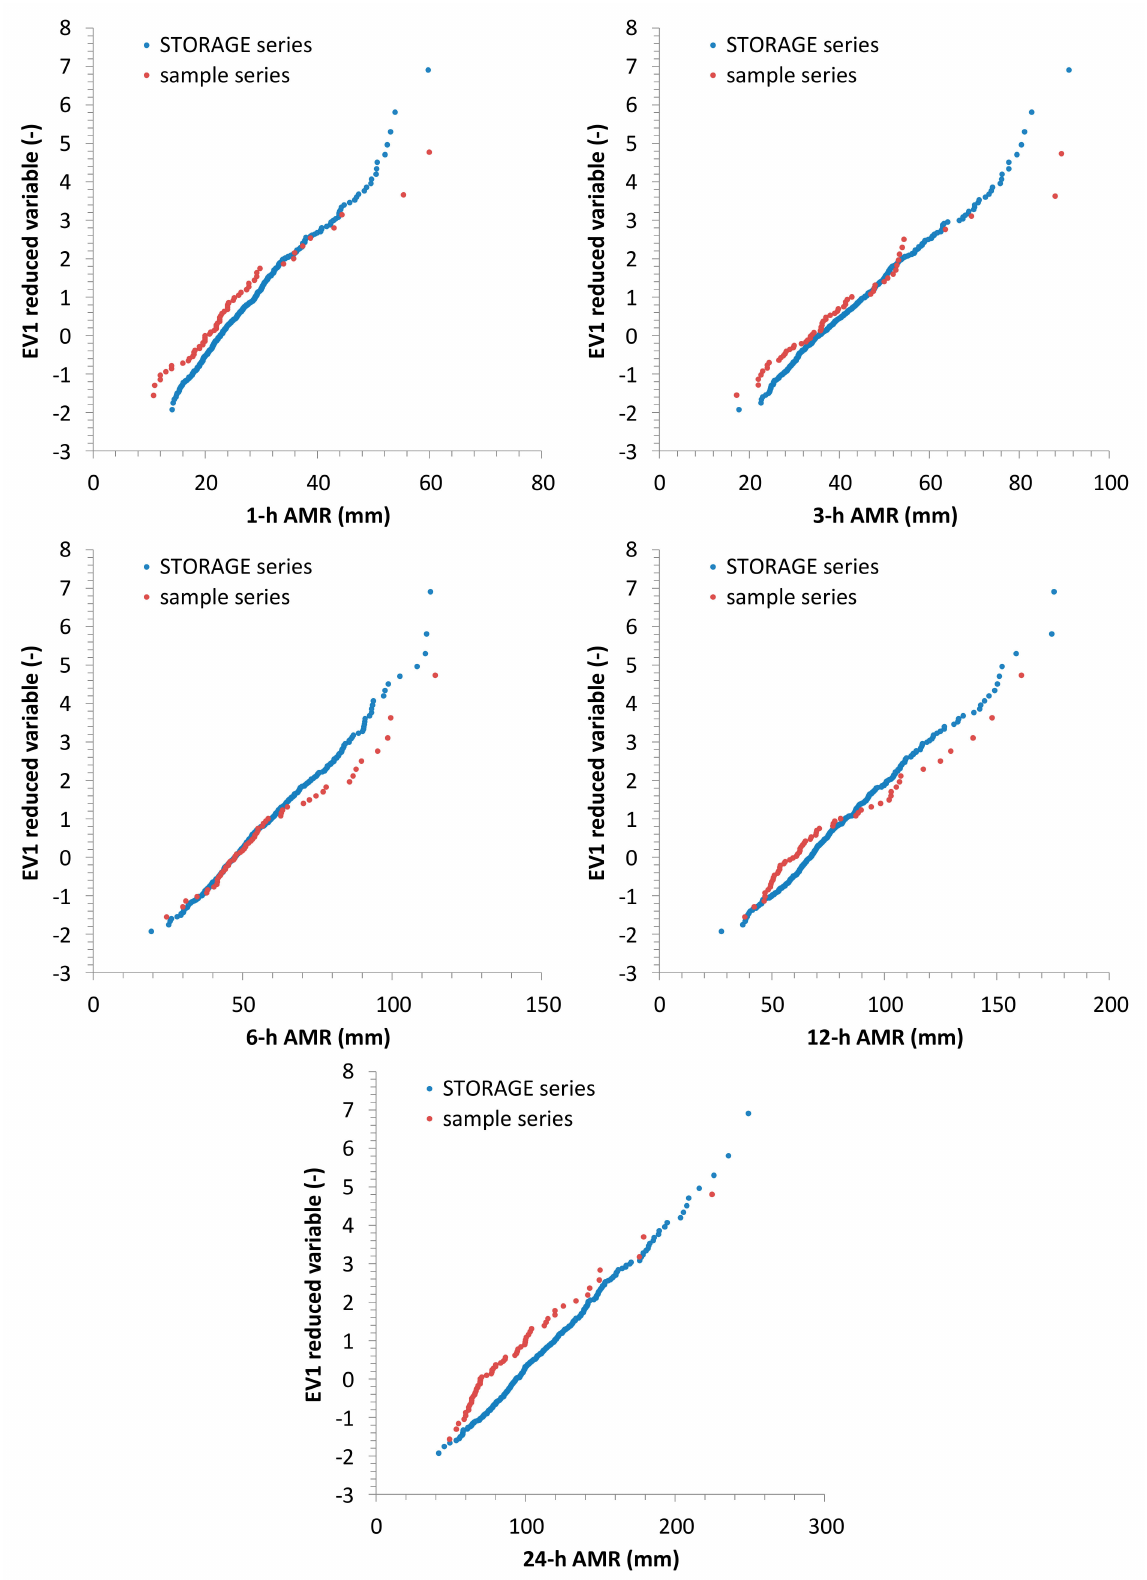
Figure 16. Montalto Uffugo rain gauge: EV1 probabilistic plots, showing the comparison among synthetic and observed AMR